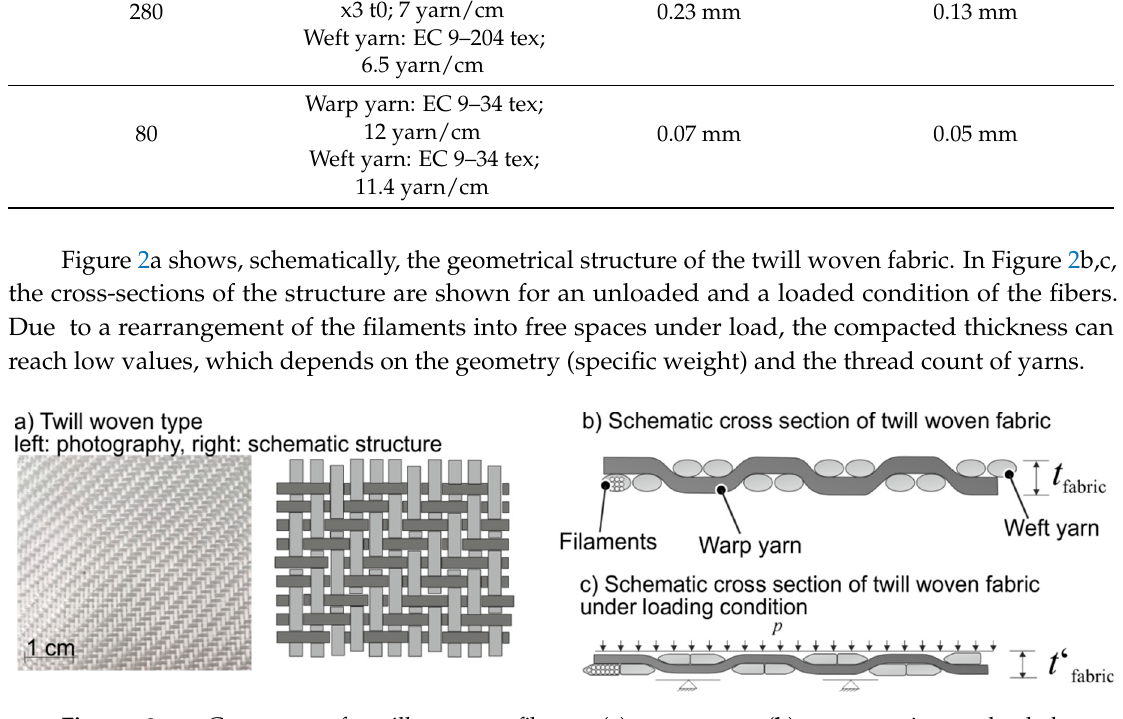
Figure 2. Geometry of twill woven fiber: ( a ) structure; ( b ) cross-section unloaded; ( c ) cross-section loaded.